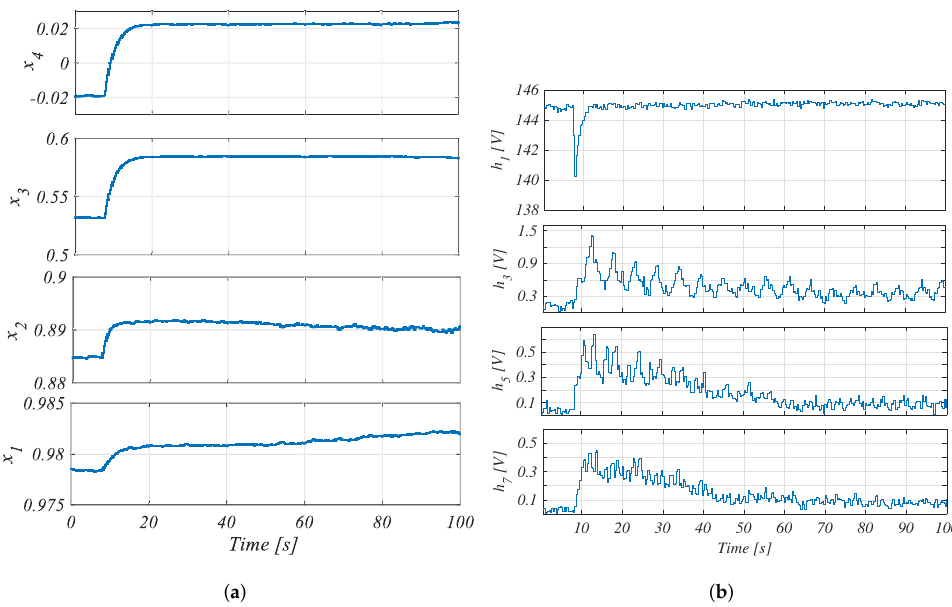
Figure 11. ( a ) Cosine of the switching-angles x k s in 200 W load insertion test, ( b ) Harmonics behavior